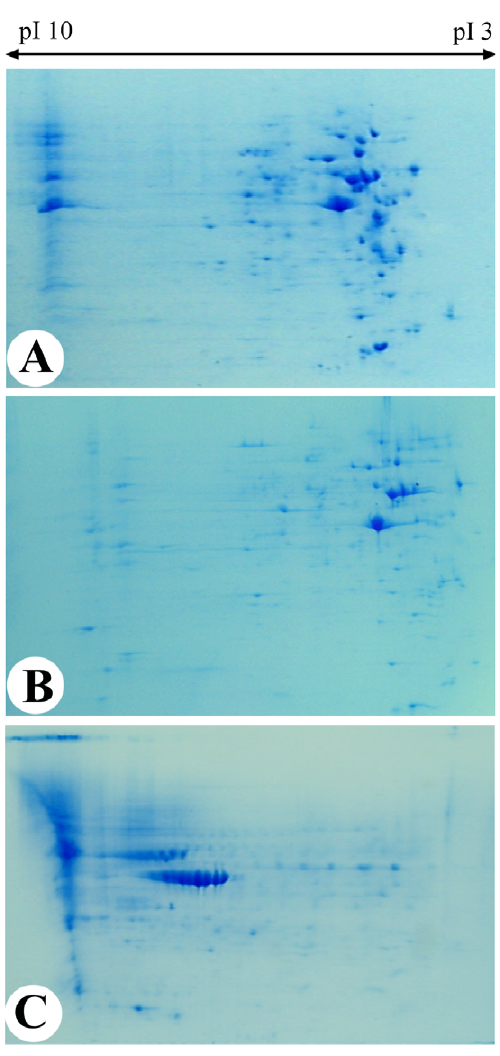
Figure 1. Two dimensional electrophoresis gels. The gels are over the broad pI range of 3 to 10 for AP cells (1A), PP cells (1B) and FP cells (1C). Note that most of the proteins in AP cells and PP cells were in the low pI region of the gel. AP cells, antlerogenic periosteum cells; PP cells, pedicle periosteum cells; and FP cells, facial periosteum cells.